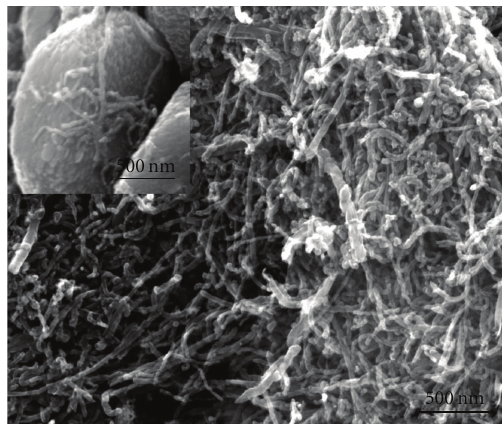
Figure 3: FE-SEM image of BiVO 4 -MWCNTs. The insert shows the limited bulk BiVO 4 formed between